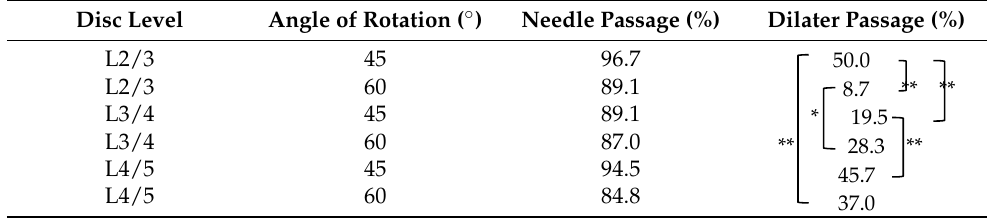
Table 3. Possible needle (1 mm) and dilater (5 mm) passage.